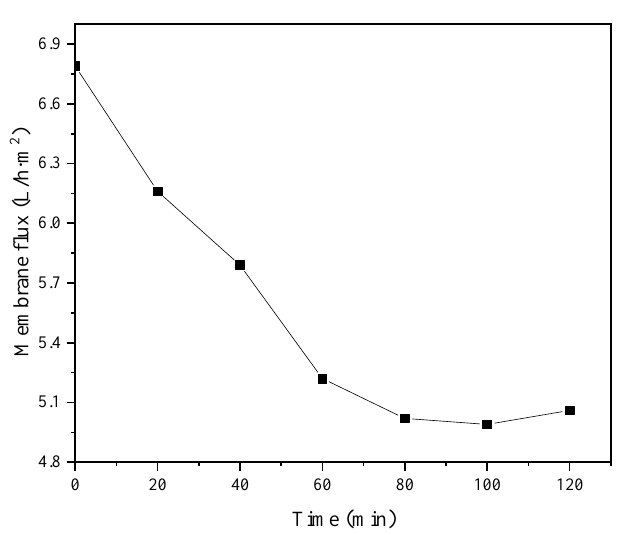
Figure 10. Effect of time on TDS.